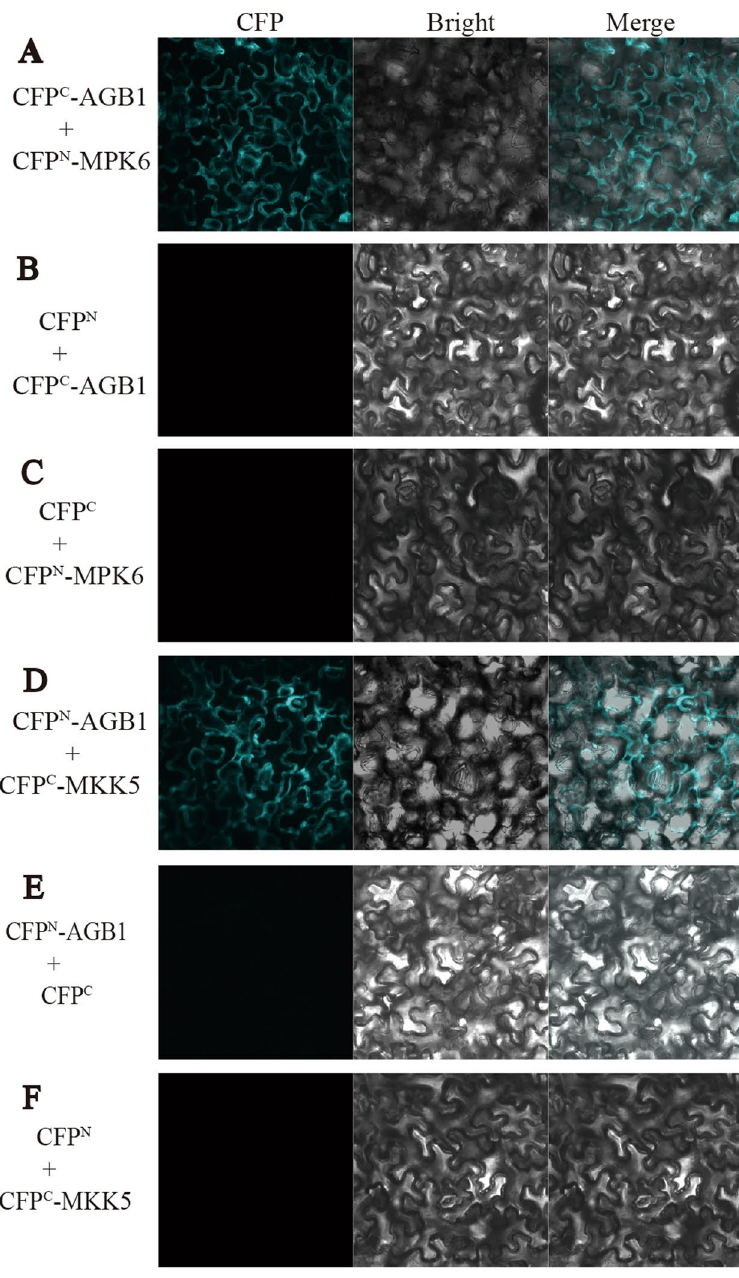
Figure 2. Bimolecular fluorescence complementation analysis showing the interaction between AGB1, MPK6 and MKK5. Images of tobacco leaf sections expressing CFP C -AGB1 and CFP N -MPK6 ( A ), CFP N -AGB1 and CFP C -MKK5 ( D ) exhibit fluorescence, but not CFP C -AGB1 and CFP N ( B ), CFP C and CFP N -MPK6( C ), CFP N - AGB1 and CFP C ( E ), or CFP N and CFP C -MKK5 ( F ). Each image is a representative of three images in three independent